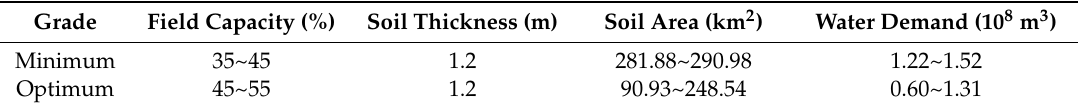
Table 3. Water demand for wetland soil.